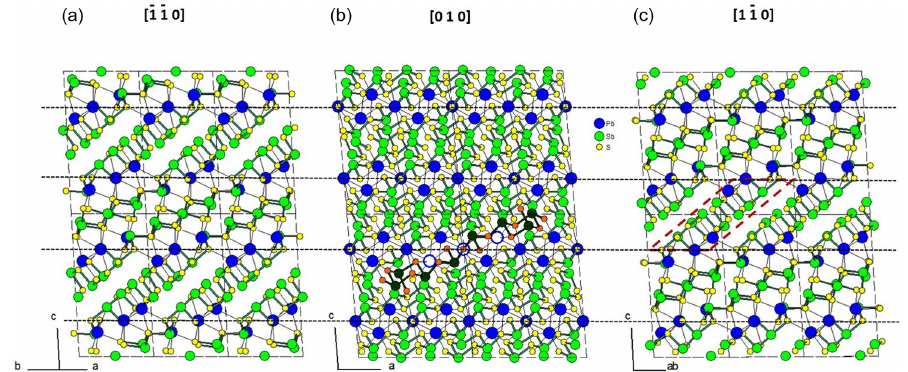
Figure 1. Crystal structure of fülöppite: projection along b (b) , [110] (a) , and [110] (c) . An Sb 8 S 15 polymer across two layers has been represented ( b – Sb: black circle; S: orange circle). In (c) a two-atom-thick ribbon has been delimited (lozenge; red tie line). Layering: black tie lines.